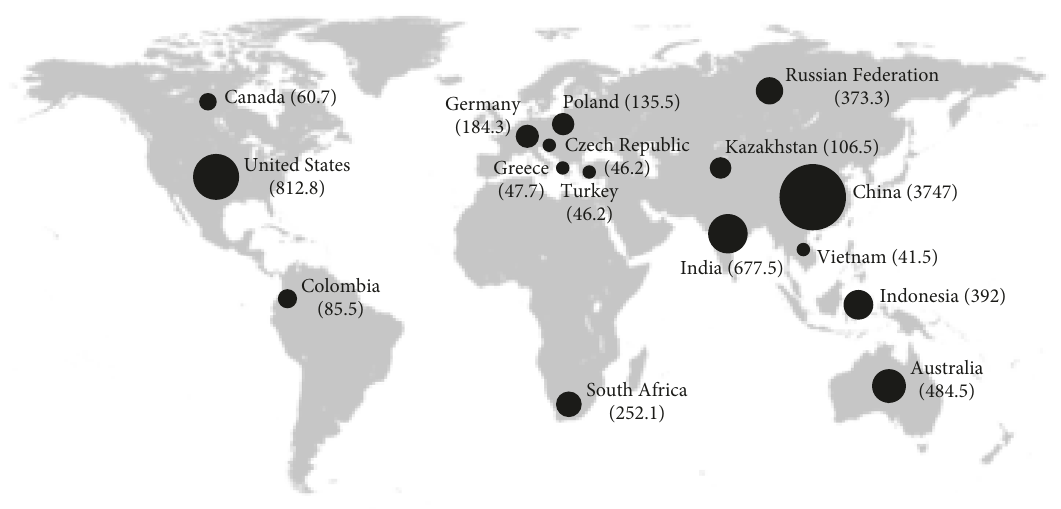
Figure 1: The coal production distributed by country in 2015 (one hundred million tons).